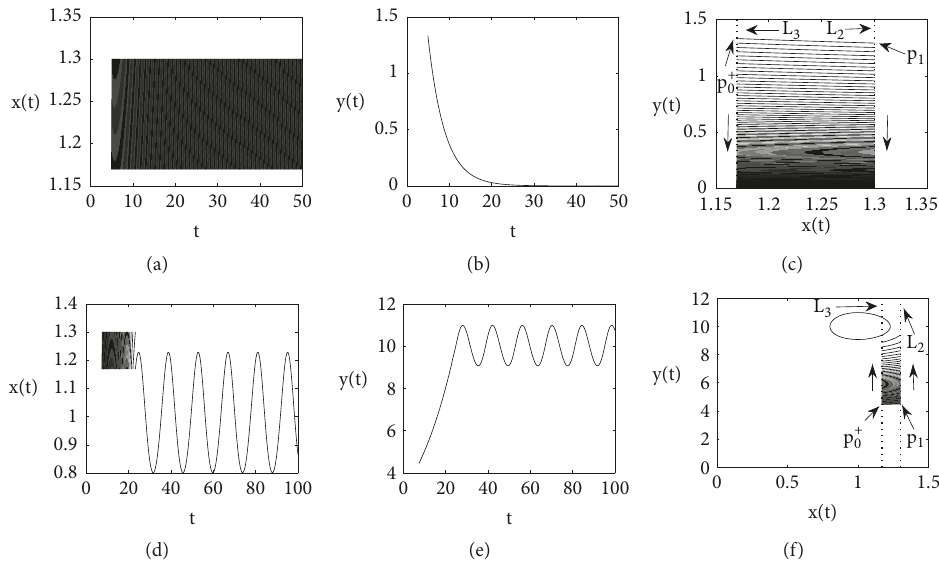
Figure 2: Stability of semitrivial order-1 periodic solution (𝑥 𝑇 (𝑡),0) . (a)-(c) Stable semitrivial order-1 limit cycle with 𝐿 2 = 𝐴/(𝑎 1 +𝑎𝑏 1 ) = 1.3 and 𝐴 𝑙 = −0.0266 , 𝑑 = 0.5 ; (d)-(f) Unstable semitrivial order-1 limit cycle with 𝐿 2 = 1.3 and 𝐴 𝑙 = 0.0049 , 𝑑 = 0.2 . All other parameter values are fixed as 𝑎 = 1 , 𝑏 = 0.1 , 𝑐 = 0.2 , 𝑎 1 = 0.5 , 𝑏 1 = 0.5 , 𝑝 = 0.1 , and 𝜏 = 0